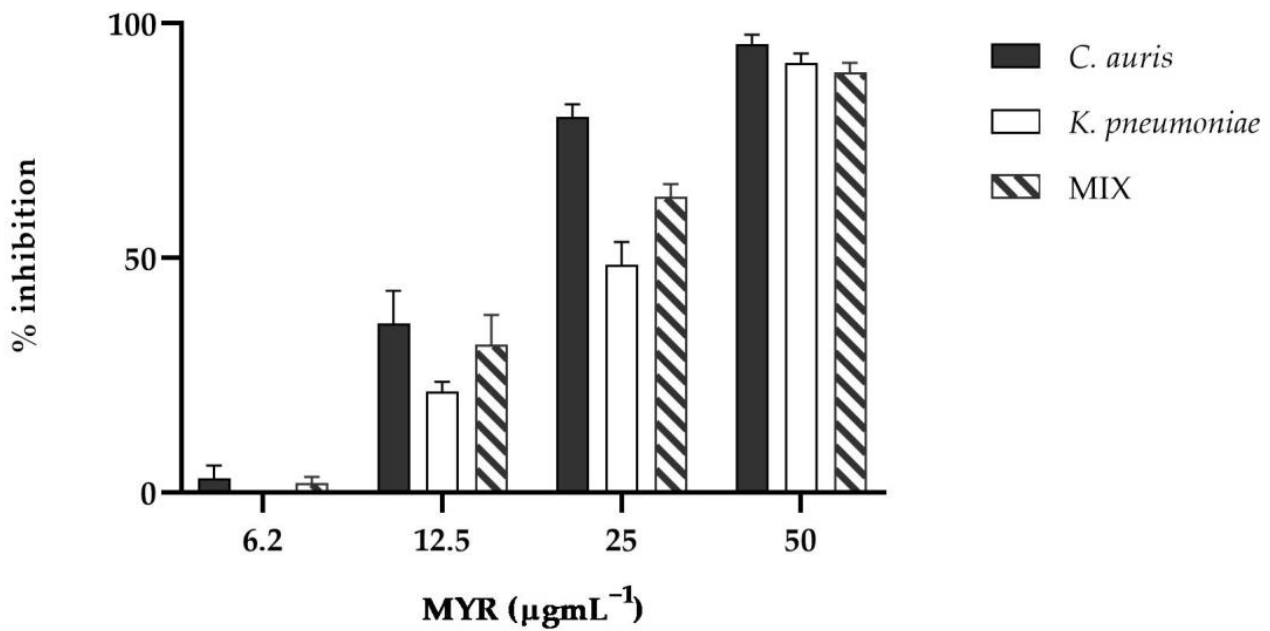
Figure 3. Antibiofilm activity of MYR on C. auris and K. pneumoniae quantified with crystal violet after 24 h.